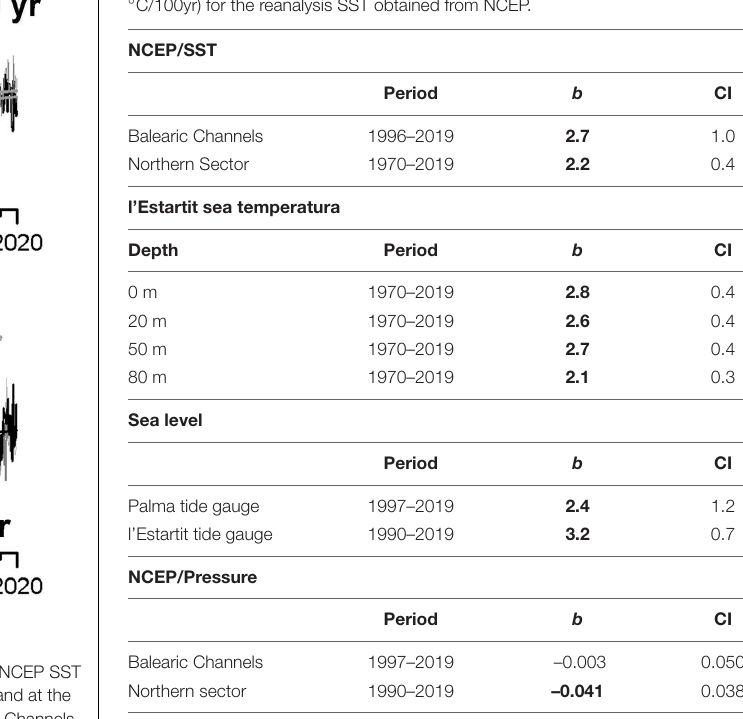
TABLE 2 | NCEP/SST: Linear trends (b) and 95% confidence intervals (CI in ◦ C/100yr) for the reanalysis SST obtained from